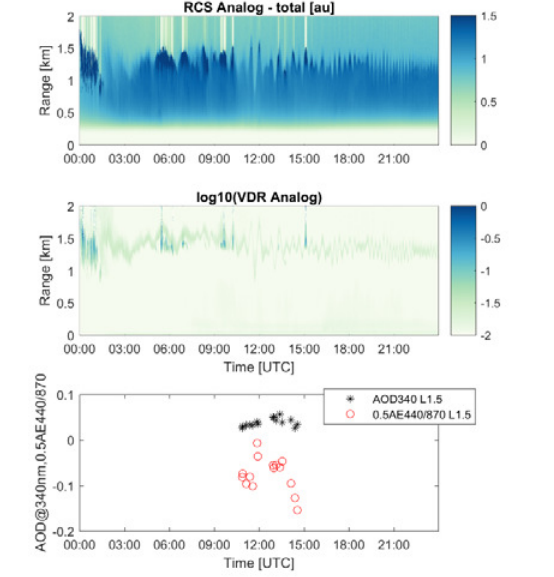
Figure 7. RCS (upper), VDR (middle) and AOD and AE (lower) at Glasgow Bishopton on 04/01/2017after a pollution event. Zoom over [0, 2] km.